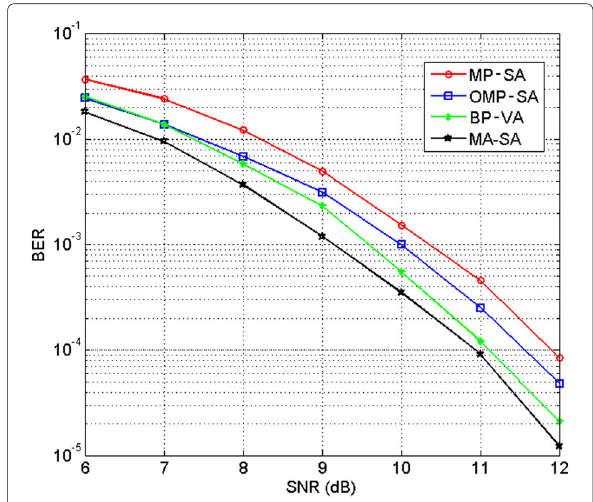
Fig. 6 Performance comparison between MP-SA, OMP-SA, BP-VA, and MA-SA. The performance for each method is computed using a length-10 training sequence for a 10-tap channel with three active taps